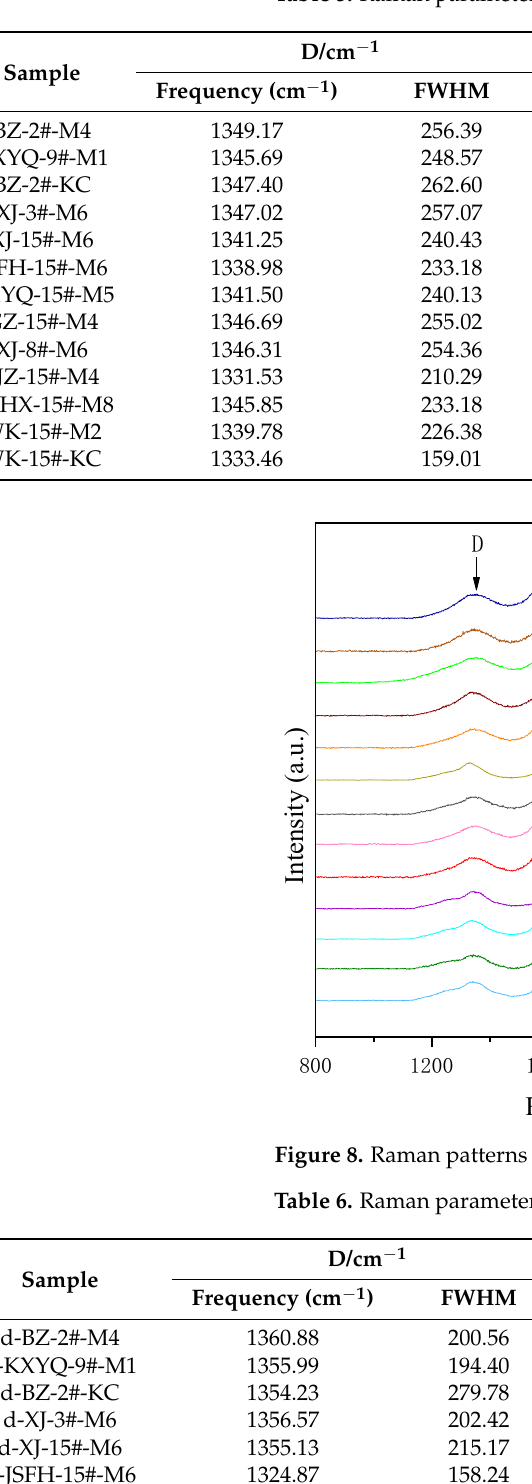
Table 5. Raman parameters of raw coal.